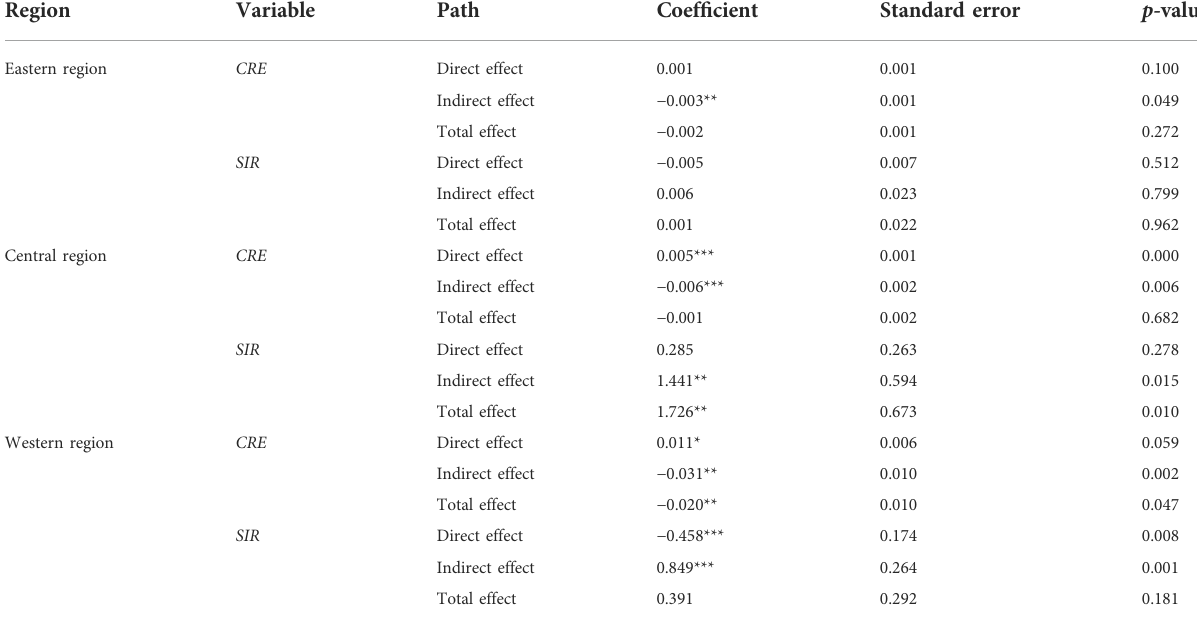
TABLE 8 Decomposition of spatial spillover effects for heterogeneity analysis.